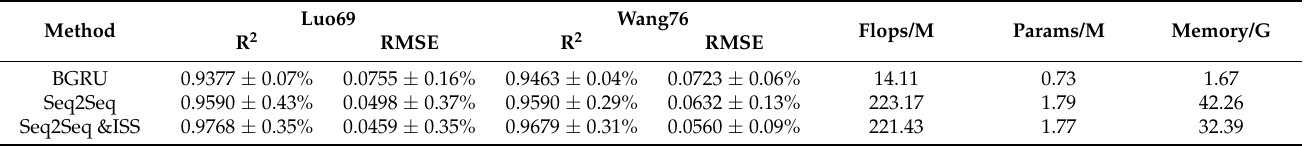
Table 2. The results obtained by the different methods based on wells Luo69 and Wang76.